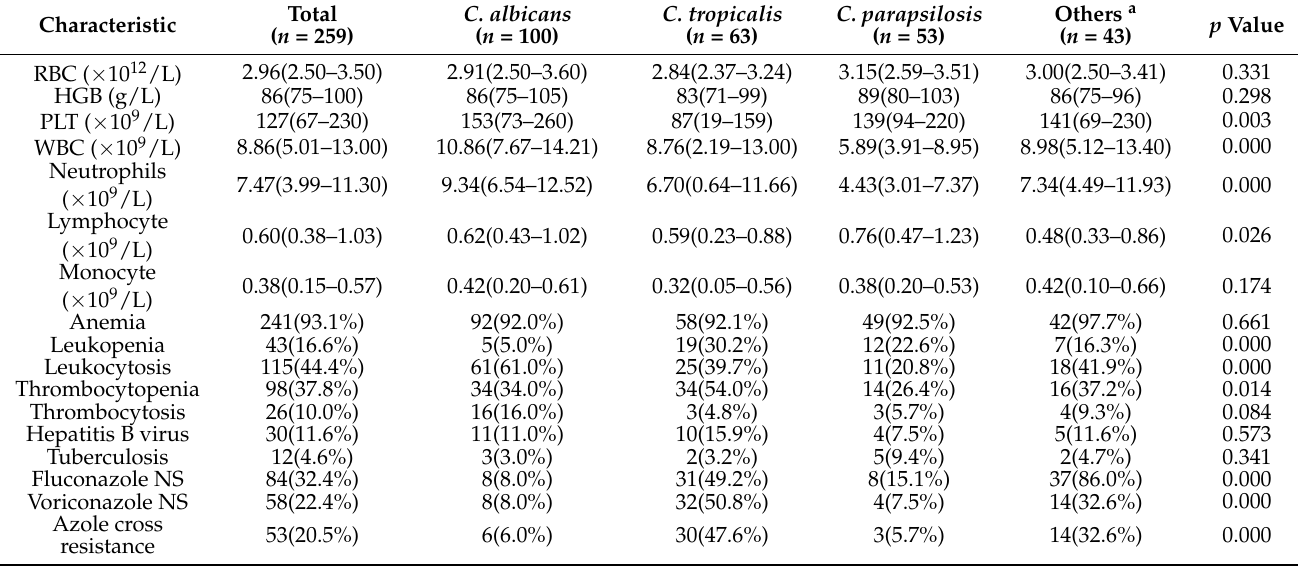
Table 3. Clinical laboratory data of patients with C. albicans and NAC